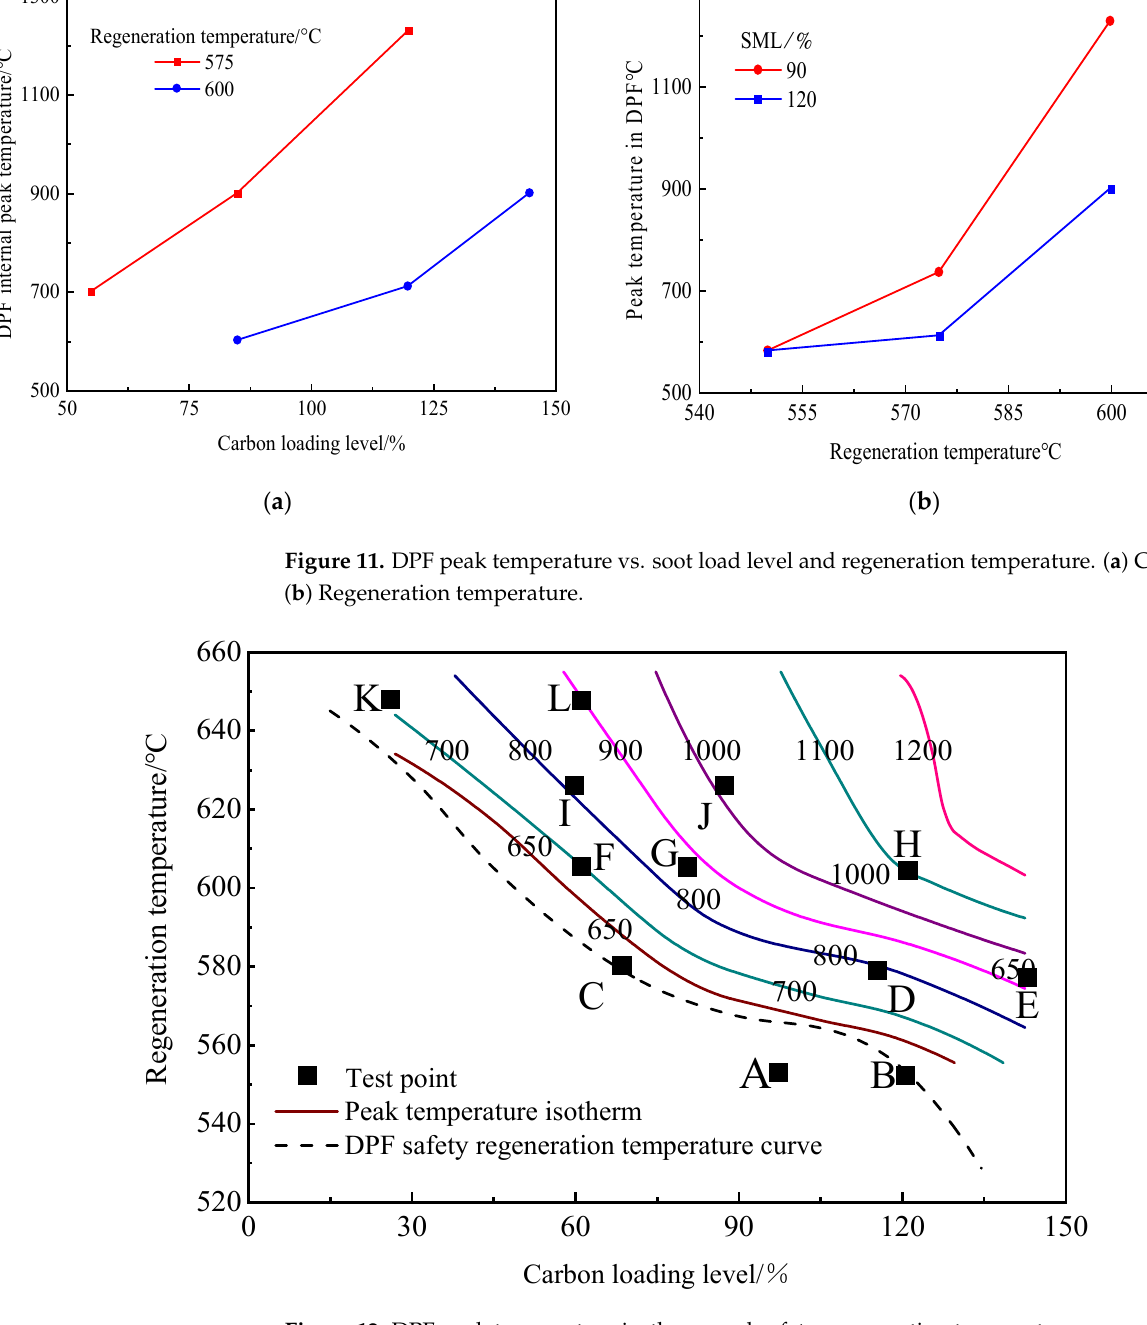
Figure 12. DPF peak temperature isotherm and safety regeneration temperature.